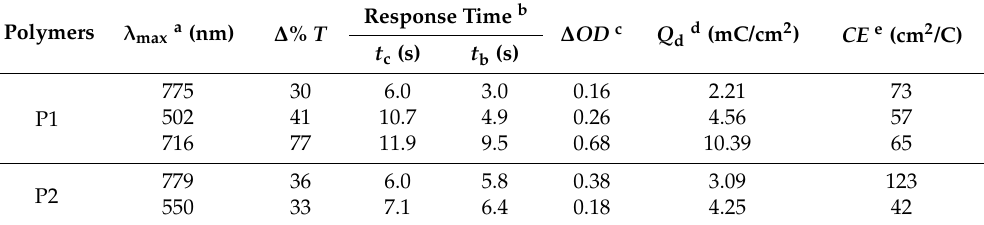
Table 2. Electrochromic properties of the polymer